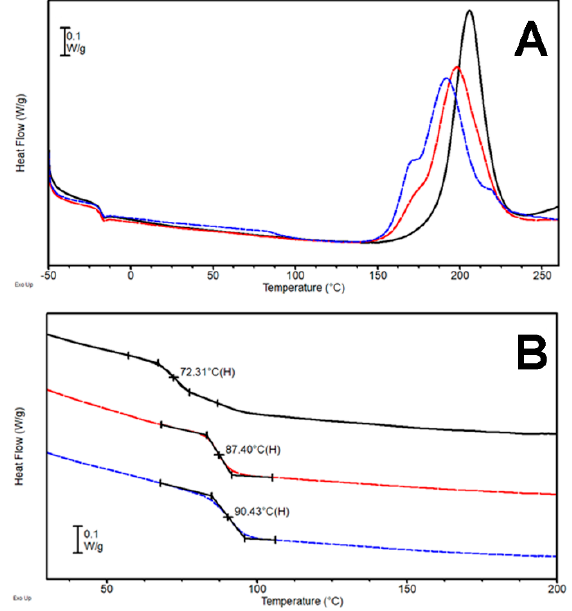
Figure 5. ( A ) DSC first heating scan (heating rate 5 °C/min) and ( B ) second heating scan (heating rate 20 °C/min) for the systems DTD-1 (—), DTD-2.5 (---), and DTD-5